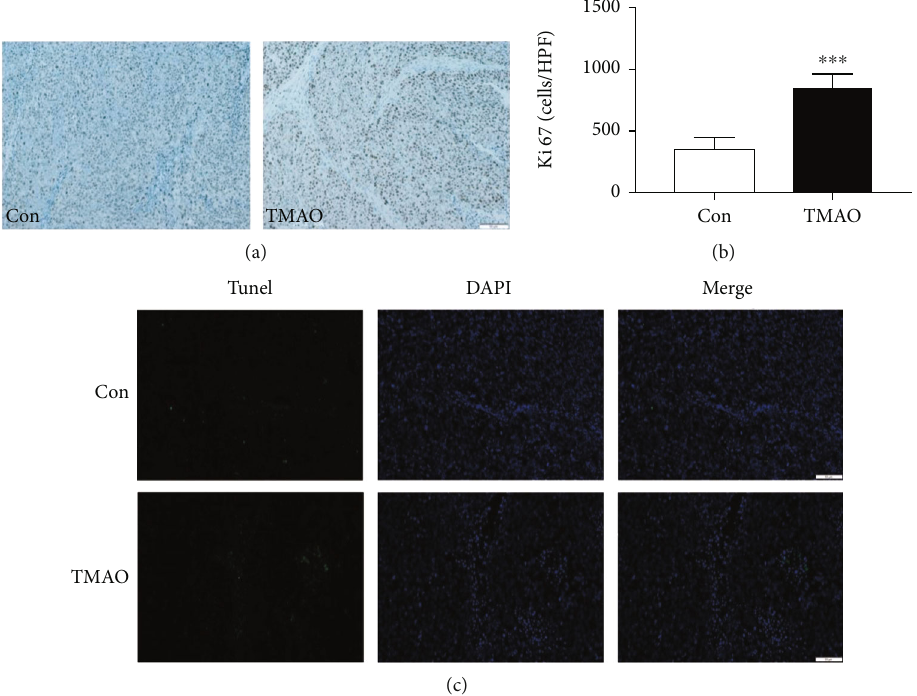
Figure 4: Choline treatment alters proliferation and apoptosis in tumor-bearing mice. (a) Immunohistochemical staining for Ki67 in tumors from implanted mice in both groups and (b) quantitative analysis. (c) TUNEL staining of tumor tissues. Con: control group; TMAO: 1.3% choline feeding. ∗∗∗ P < 0 : 001 versus Con group ( n = 5